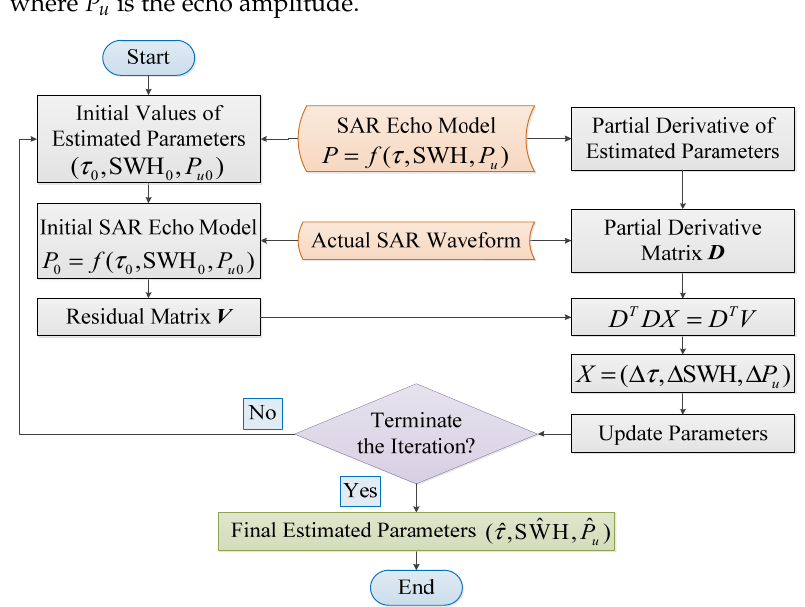
Figure 8. Flowchart of re-tracking algorithm implementation step.